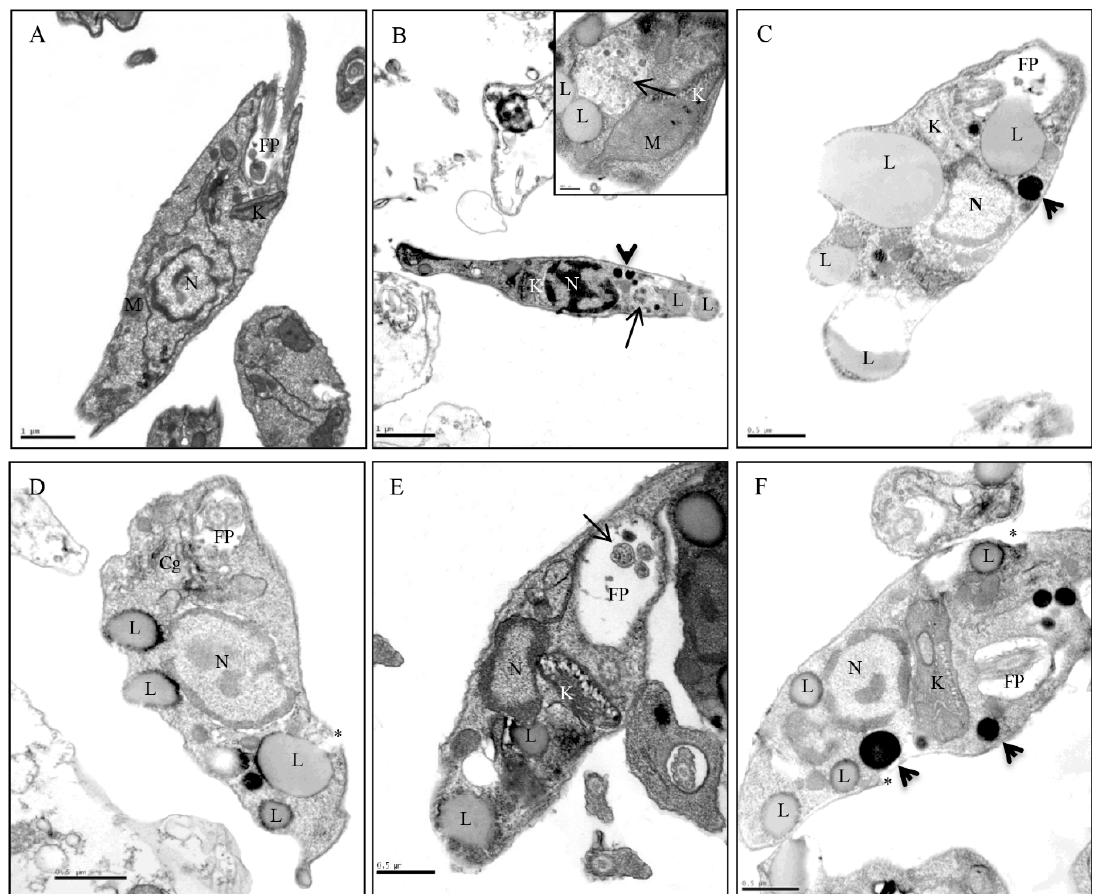
Figure 4. Transmission electron microscopy of Leishmania amazonensis promastigote forms treated for di ff erent times with Endlicheria bracteolata (7.93 µ g / mL). ( A ) Untreated parasites showing the characteristic structure of kinetoplastids (K), flagellar pocket (FP), and nucleus (N). ( B ) Promastigotes treated for 2 h showing electron-dense structures (arrowhead), in the box above note the presence of multivesicles (arrow), mitochondrial swelling (M) and presence of lipid droplets (L). ( C ) 4 h of treatment showing kinetoplast swelling (K), increased number of lipid droplets (L) and electron-dense structures (arrowhead). ( D ) 8 h of treatment showing large lipid droplets close to the plasma membrane (L) and discontinuity of the plasma membrane (asterisk). ( E ) 16 h of treatment showing kinetoplast swelling (K), lipid droplets (L) and multivesicles inside the flagellar pocket (FP) (arrow). ( F ) promastigotes after 24h of treatment showing increased volume of the kinetoplast (K), increased number of lipid droplets (L) and electron-dense structures (arrowheads).